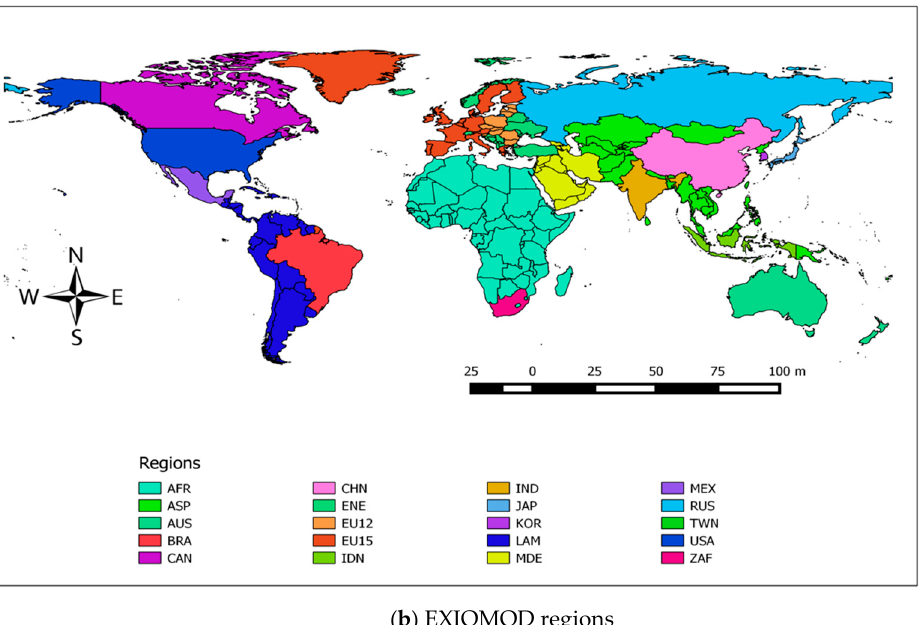
Figure 4. Classification of regions in GCAM and EXIOMOD.